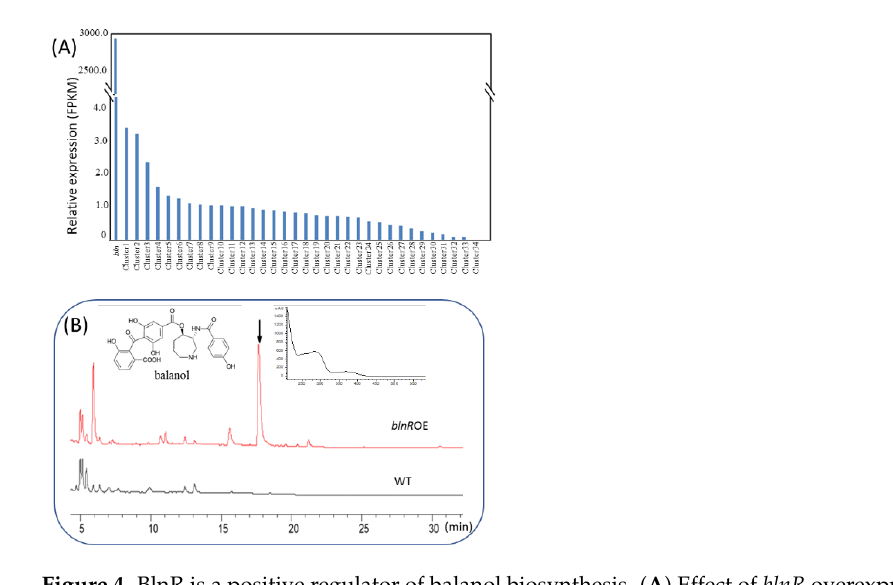
Figure 4. BlnR is a positive regulator of balanol biosynthesis. ( A ) Effect of blnR overexpression on the transcriptional level of other gene clusters. ( B ) Metabolite profile of wild-type and blnR OE strains after cultivation in COB medium for 10 days.